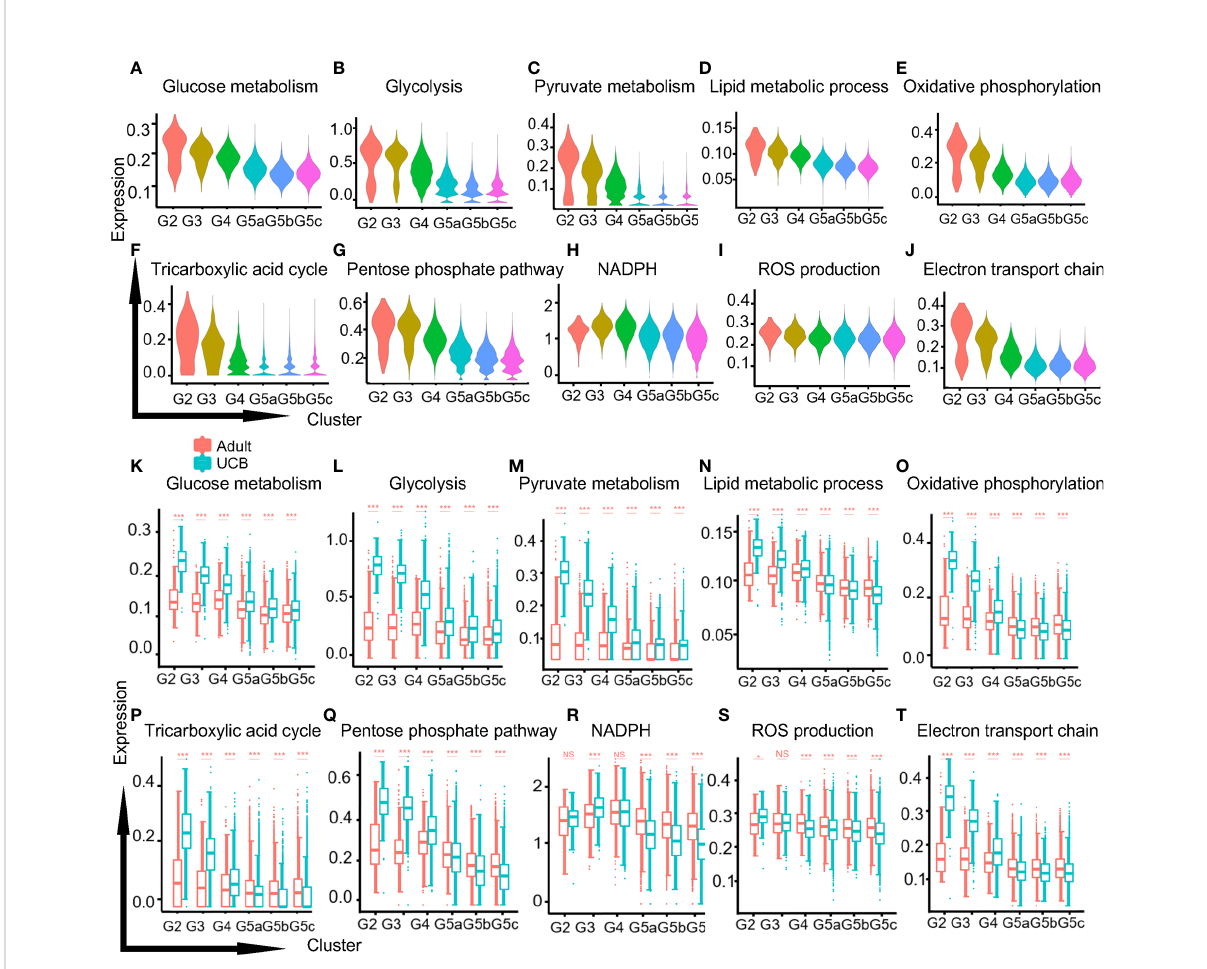
FIGURE 6 Metabolic characteristics of neutrophil subgroups. (A – C) The violin plots of glycol-metabolism-related functions scores in each subgroup. Glucose metabolism (A) , glycolysis (B) and pyruvate metabolism (C) . (D) The violin plot of lipid metabolism function score. (E, F) The violin plots of mitochondria related metabolism functional scores in each subset. Oxidative phosphorylation (E) and the tricarboxylic acid cycle (F) . (G – J) The violin plots of functions scores in metabolism-related ROS production of each subset. Pentose phosphate pathway (G) , NADPH (H) , ROS production (I) , electron transport chain (J) . (K – T) Box plots of function scores of the metabolic pathways in UCB and healthy adults. *p < 0.05, ***p < 0.001, NS, not